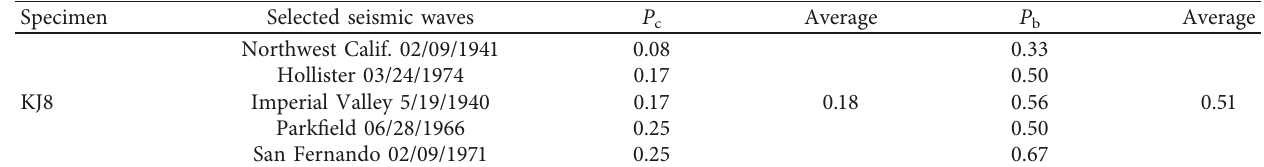
Table 20: Plastic hinge rates of beams and columns in model KJ8.